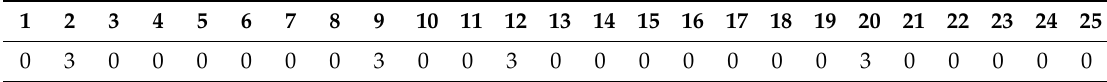
Table 8. Optimal individual coding.